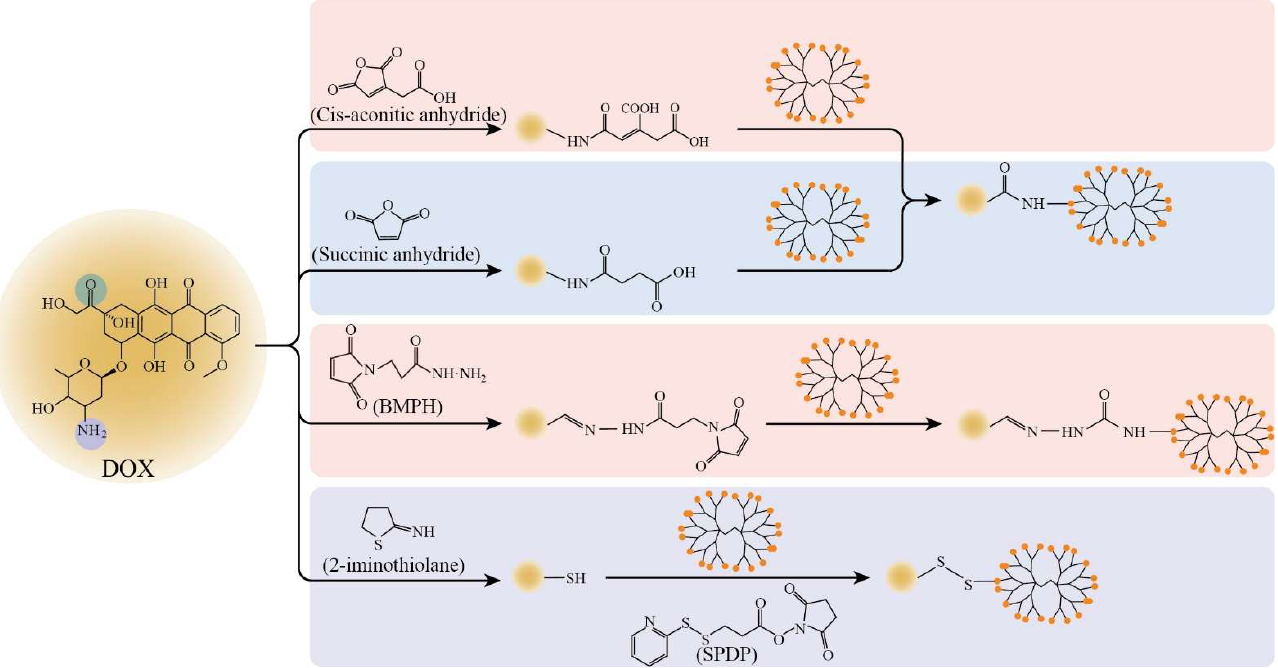
Figure 3. Schematic diagram of the formation process of different linkers between drugs and PAMAM. Different background colors represent the synthesis of linkers with different release properties: pink for acid-sensitive, blue for non-acid-sensitive and purple for GSH-sensitive. DOX is taken as an example of a drug. DOX: doxorubicin; BMPH: N-(β-maleimidopropionic acid) hydrazide; SPDP: N-succinimidyl-3-(2-pyridyldithio) proprionate. Cis-aconitic anhydride has a five-membered, unsaturated, oxygen-containing ring,